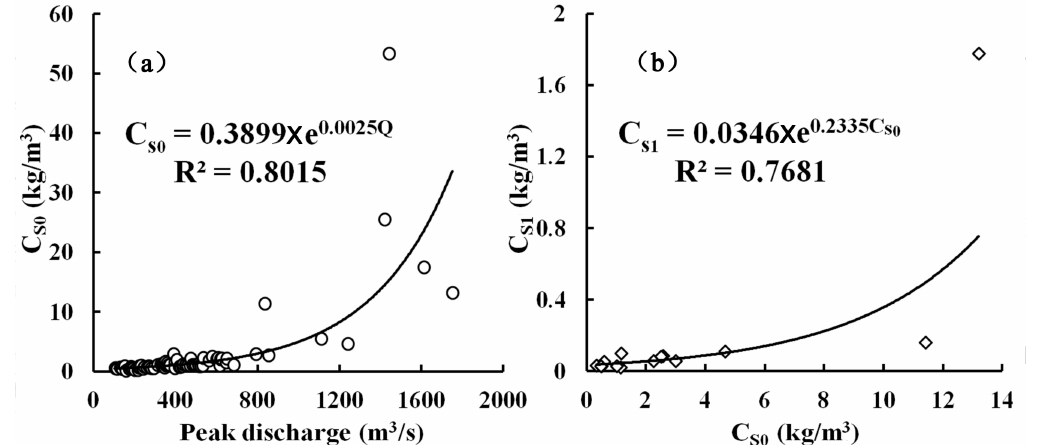
Figure 3. Relationships between ( a ) inflow peak discharge and inflow suspended sediment concentration (C S0 ) and ( b ) C S0 and suspended sediment concentration at site S1, the entrance to the main reservoir (C S1